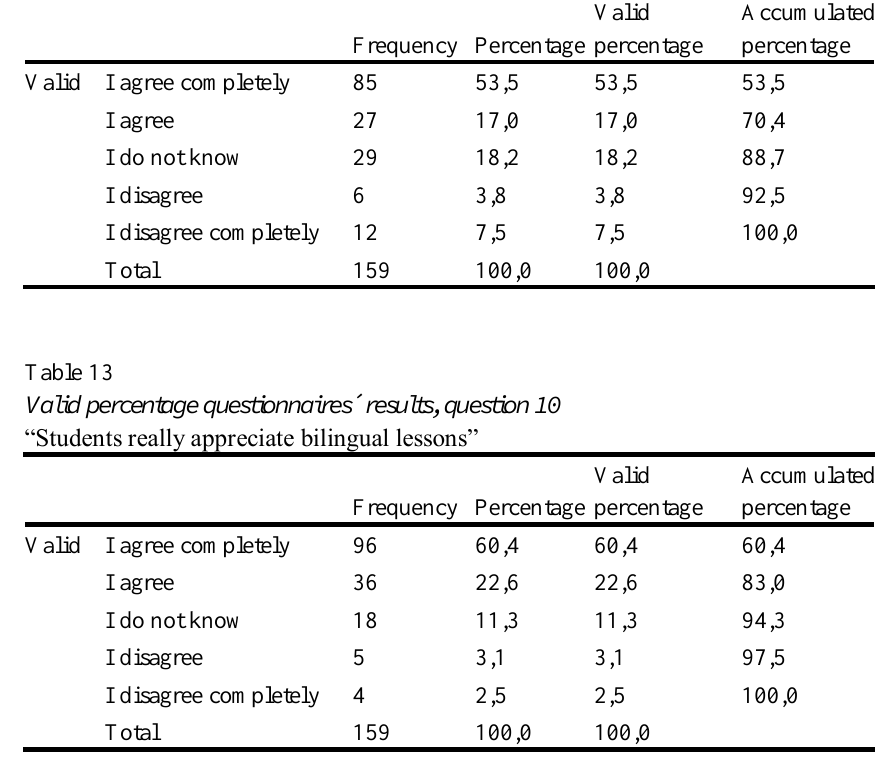
Valid percentage questionnaires´ results, question 9 “Students are pleased with using the second language among peers and the teacher”.